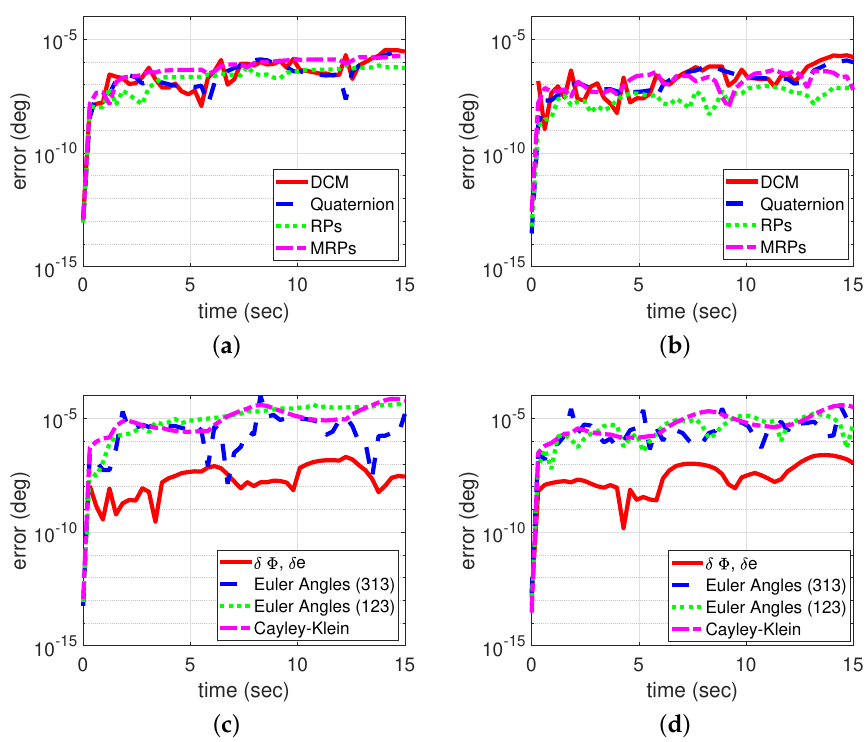
Figure 2. Validation test. (large angular rotation δφ = [ 145, 170 ] deg). ( a ) Kinematics error 1. ( b ) Kinematics error 2. ( c ) Kinematics error 1. ( d ) Kinematics error 2. DCM = Direction Cosine Matrix; RP= Rodrigues parameters; MRP= Modified Rodrigues